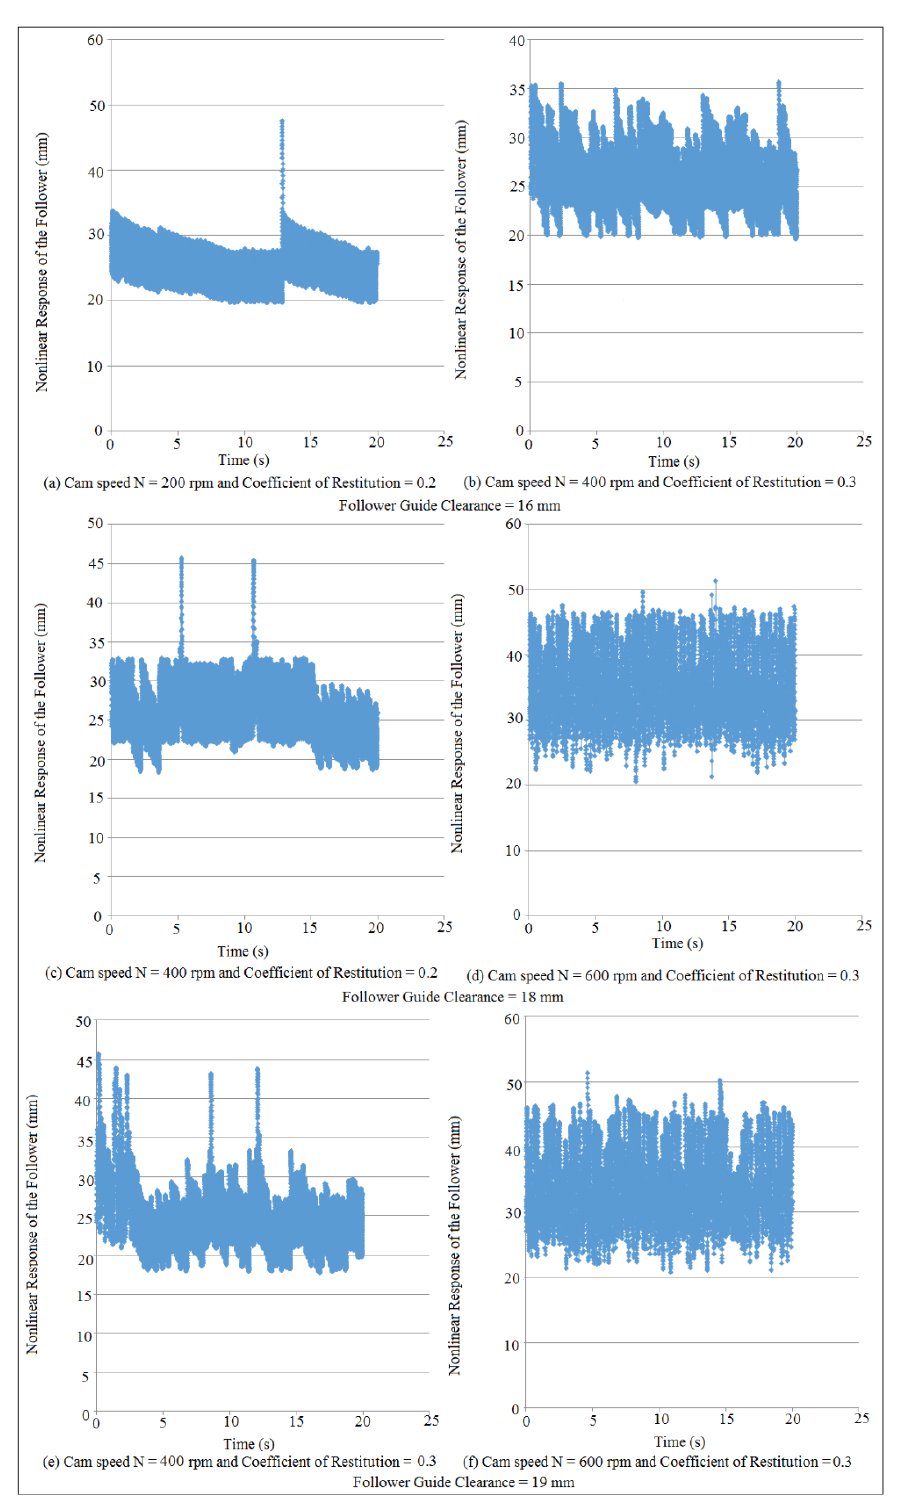
Figure 16. Nonlinear response mapping of the follower when the follower offsets to the right (O = 30 mm).